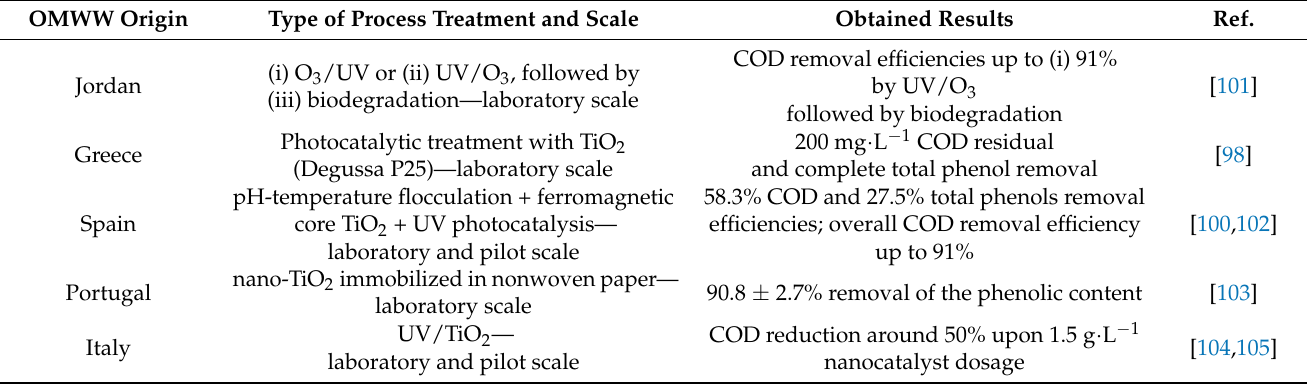
Table 2. State of the art of UV photocatalysis used to treat OMWW. Adapted from Reference [100]. OMWW Origin Type of Process Treatment and Scale Obtained Results Ref.